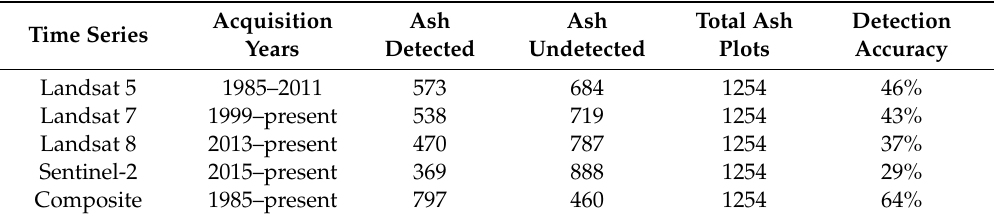
Table 4. NDVI time series accuracy summary table by satellite sensor.